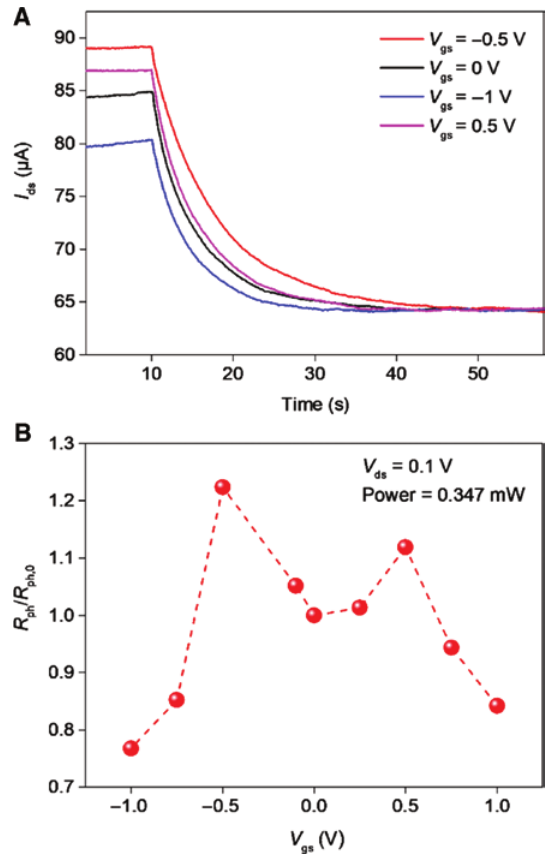
Figure 5: The gate-voltage-dependent photoresponse of the TiO NPs decorated GFET photodetectors.